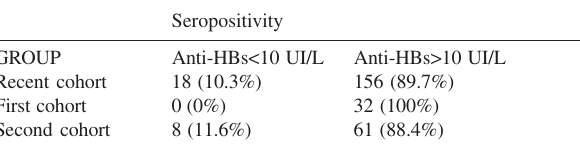
Table 4 - Age at the third HBV vaccine dose versus seroconversion, by stratification into 3 age groups